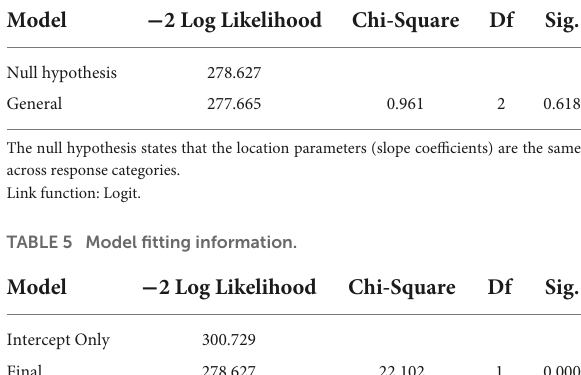
TABLE 4 Test of parallel lines.